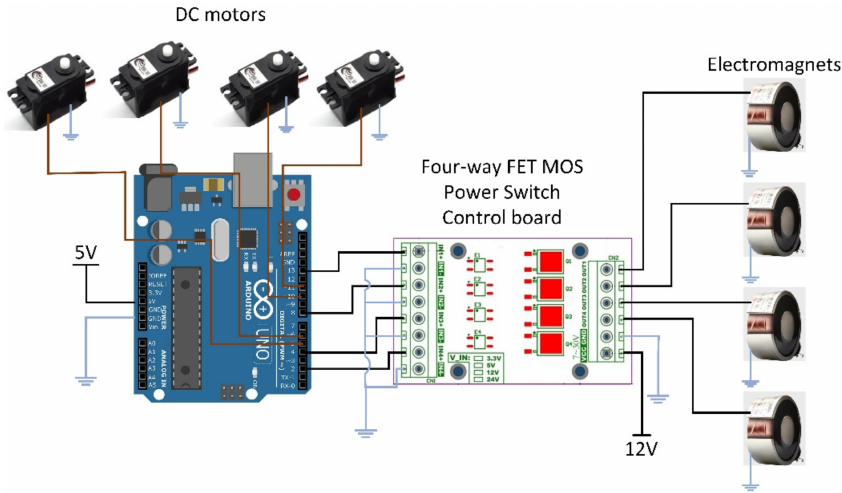
Figure 16. Schematic diagram of the control circuit of the electromagnetic sliding